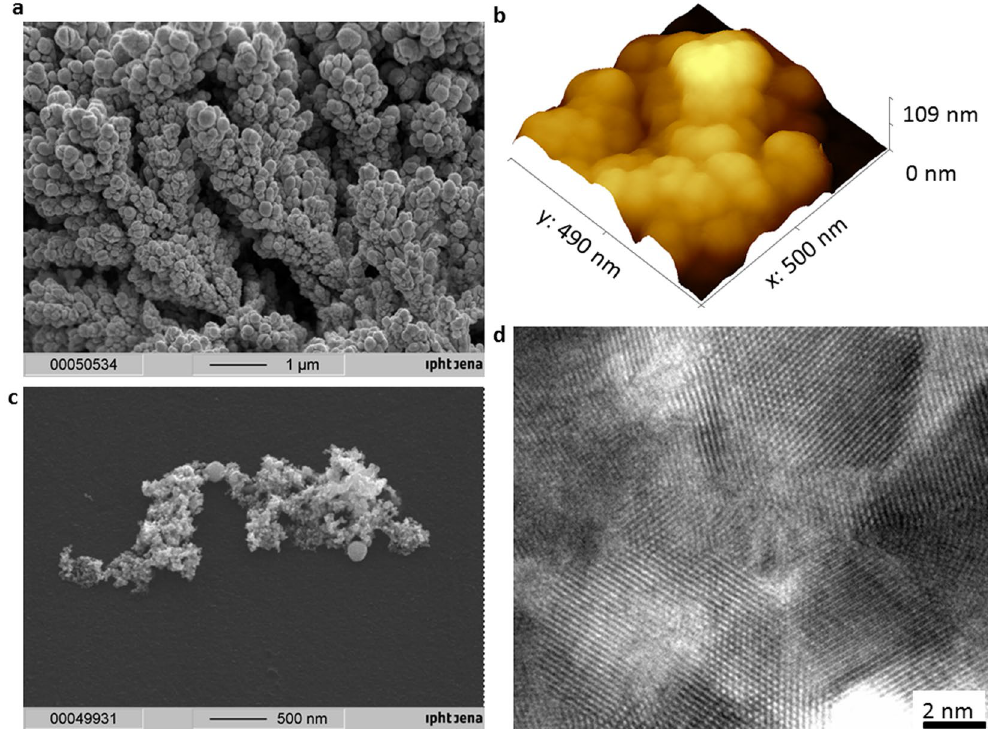
Figure 1. Platinum black morphology. ( a ) SEM image of the platinum black electrochemically synthesized on platinum substrate. ( b ) AFM image of the platinum black; ( c ) SEM image of the platinum black immobilized on carbon substrate. ( d ) HRTEM image of the platinum crystals.